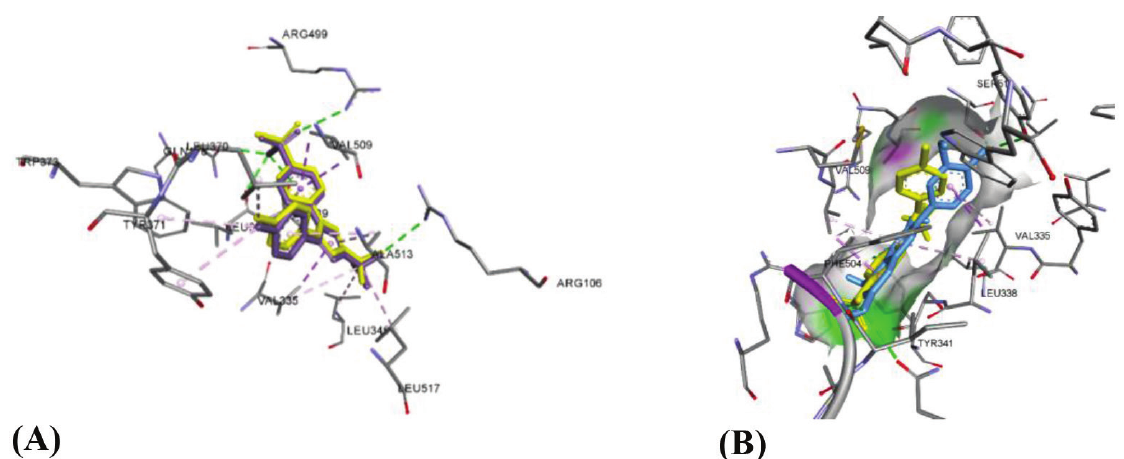
Figure 7. 3D visualization of ( A ) allocation and interaction with amino acid residues of the active site of COX-2 native celecoxib 51 and reference ligand (yellow molecule) ( B ) compatible conformation of the native celecoxib ligand (yellow molecule) with quercetin (blue molecule).